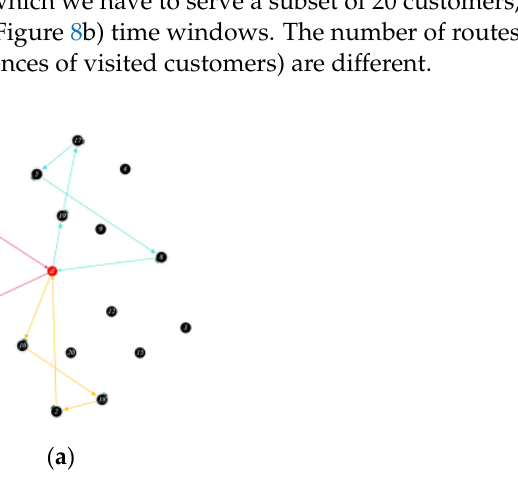
10 of 13 Figure 6. Impact of time window durations on optimality gap (%) and computational time (secs). We are also interested in evaluating the impact of time windows duration on the quality of the solutions. In the graph shown in Figure 7, we can observe the relation be- tween the time window duration and the total quantities of delayed deliveries. The time window durations seem to have a soft effect on the delayed deliveries.